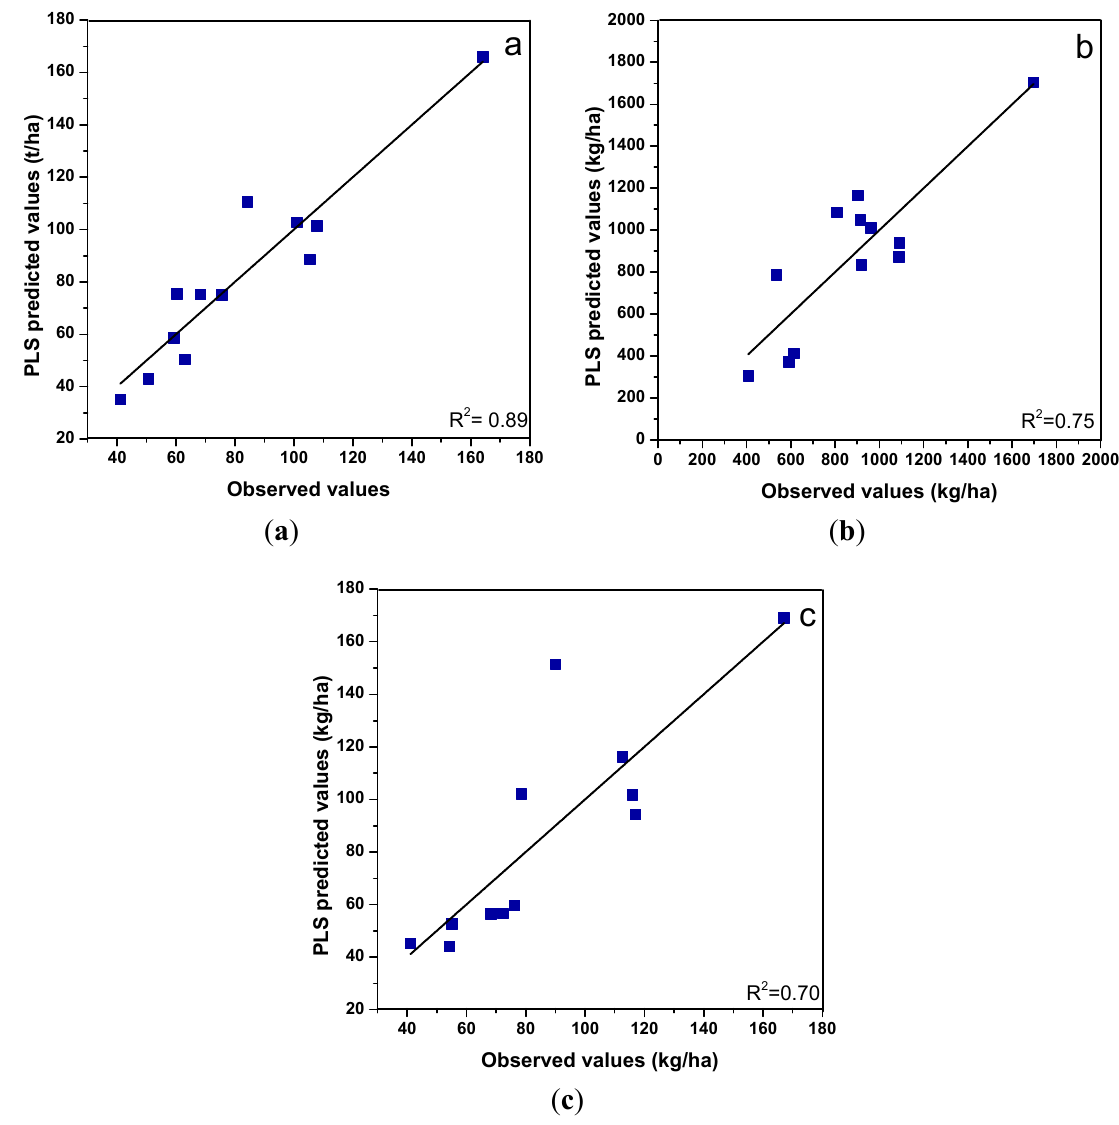
Figure 4. Observed values versus PLSR predicted values for: (a) plant biomass; (b) N uptake; and (c) P